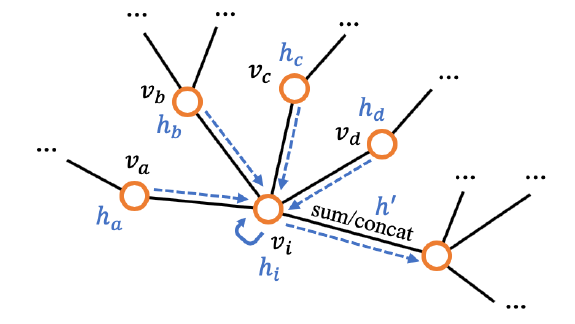
Figure 4. Attention